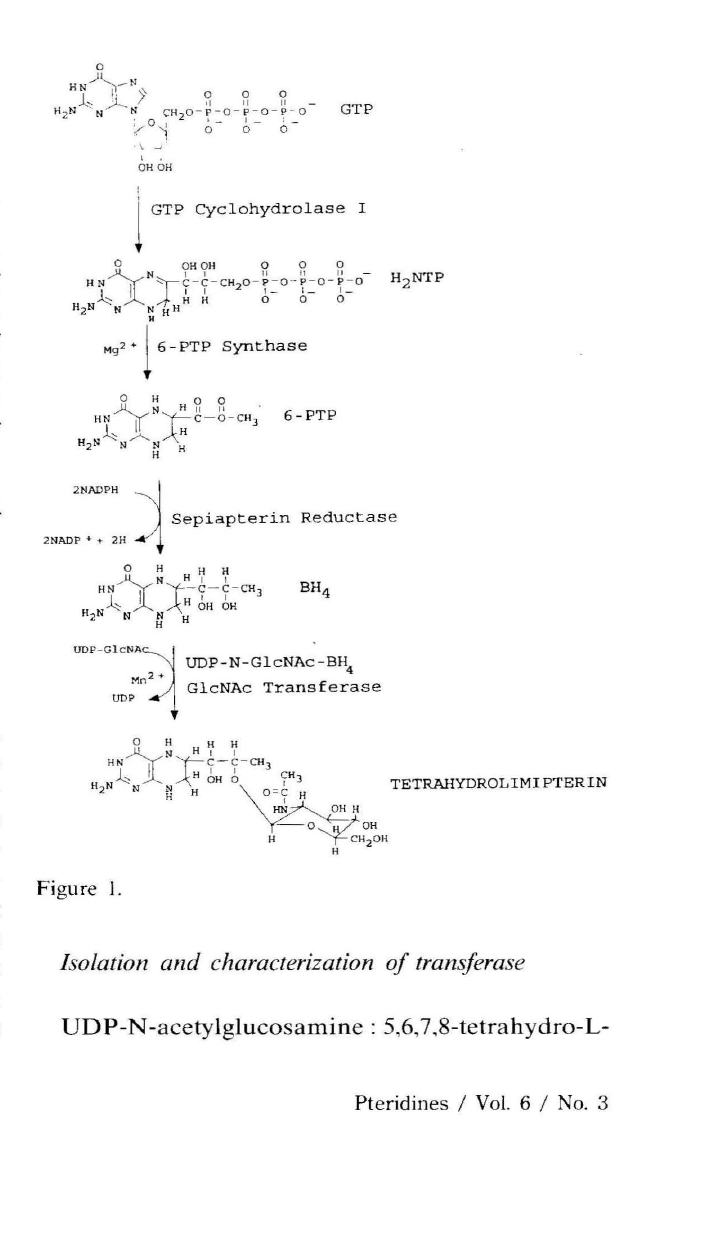
Pteridines I Vol. 6 I